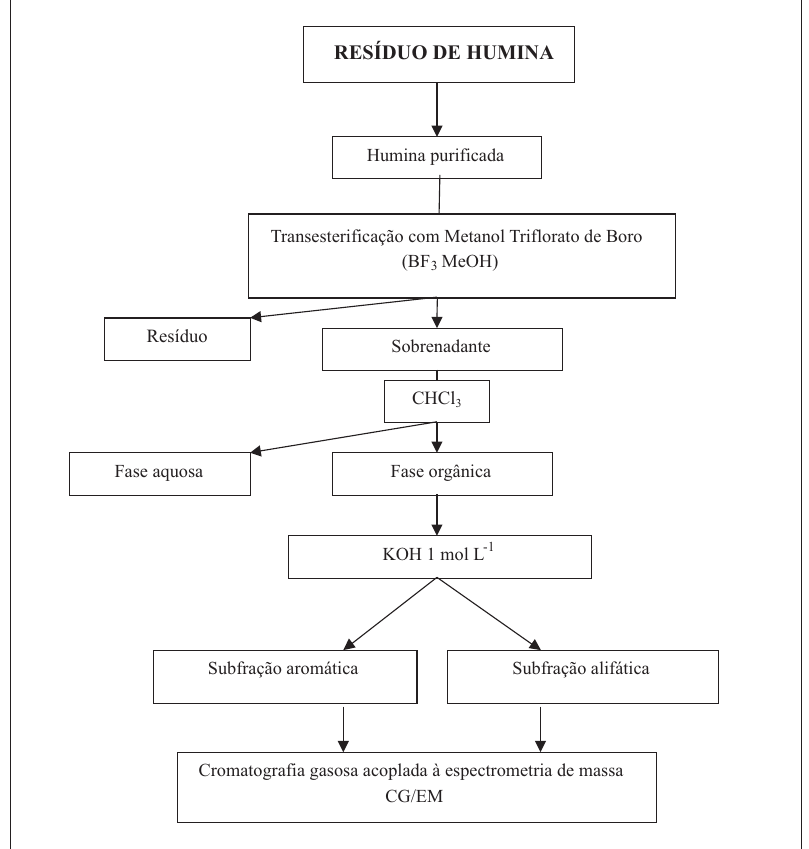
Figura 1. Esquema ilustrando o processo de purificação e extração da humina, preconizado por Kolattukudy et al. (1975) e Almendros & Sanz